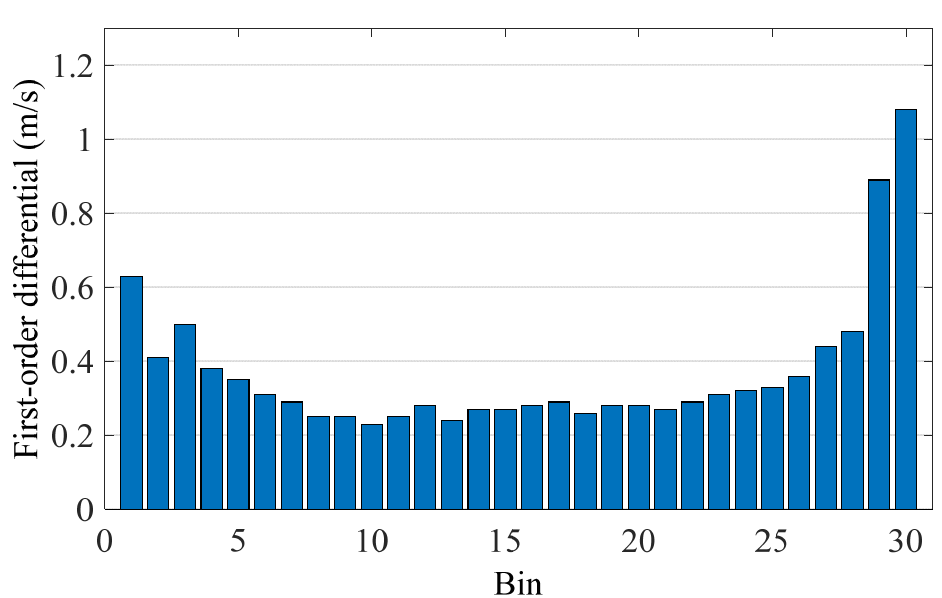
Figure 8. Wind speed frequency histogram.